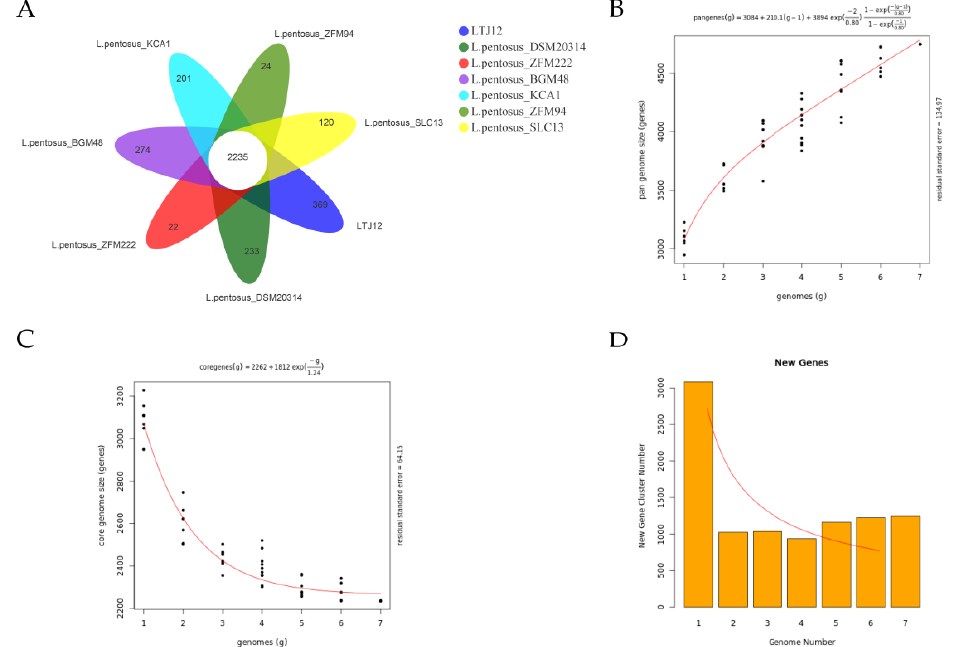
Figure 7. Pan and core genes of L. pentosus . ( A ) Venn diagram displaying the unique and core genes. ( B ) The curve of pan genome size changing with the number of genomes. The abscissa was the number of genomes, and the ordinate was the pan genome size. ( C ) The curve of core genome size changing with the number of genomes. The abscissa was the number of genomes, and the ordinate was the core genome size. ( D ) Column chart and curve of new gene size changing with the number of genomes. The abscissa was the number of genomes, and the ordinate was the new genome size. Collinearity generally means that certain regions between chromosomes in different species have similar gene arrangement. In the process of evolution, the factors that affect gene collinearity include chromosomal recombination and gene transposition. In general, the farther the evolutionary distance between species, the worse the gene collinearity, so the degree of collinearity between two species can be used as a measure of the evolution- ary distance between them. At the same time, we can also obtain the structural variation of genomes between species during the evolution process through collinearity analysis. The collinearity comparison analysis of the genomes of strain LTJ12 and 8 strains of L. pentosus downloaded from NCBI was performed with Mauve software. The Mauve alignment of the nine genomes identified approximately 17 – 22 Locally Collinear Blocks (LCBs, filled with different colors) separated by specific DNA stretches of different lengths (Figure 8). Identical colored regions are connected with lines that indicate which regions in these genomes are homologous. Mauve Alignment also detected a large number of chromosomal insertions, arrangements, and inversions. However, the synteny of genes was similar. Inversions and rearrangements are major evolutionary phenomena observed among L. pentosus strains and provide a complete picture of the genetic differences among strains colonizing different ecological niches [42].